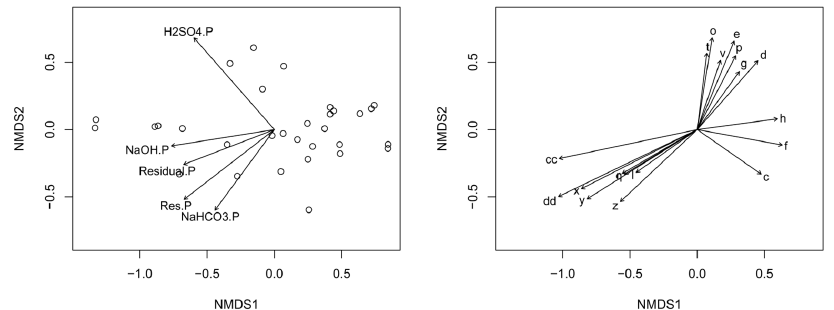
Figure 6. Non-metrical multidimensional scaling (NMDS, left panel ) of the P fractions of the sediment and fitting of the environmental predictors ( right panel ). Only parameters with a level of significance of p < 0.1 are shown. Parameters: c—agriculture, d—forest, e—open water, f—urban, g—